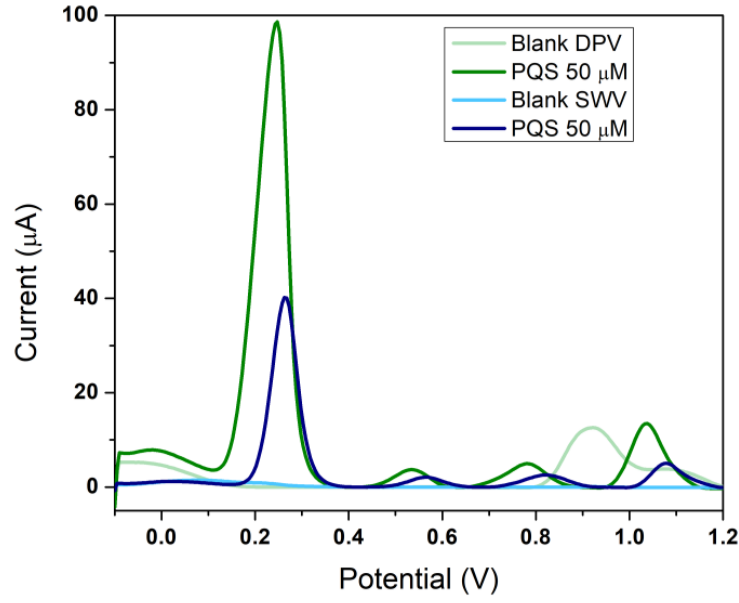
Figure 4. The influence of the electrochemical technique for PQS detection: blank (H 2 SO 4 0.5 M) analysis by DPV ( light green ) and SWV ( cyan ); analysis of a 50 µM PQS solution by DPV ( dark green ) and SWV ( dark blue ).